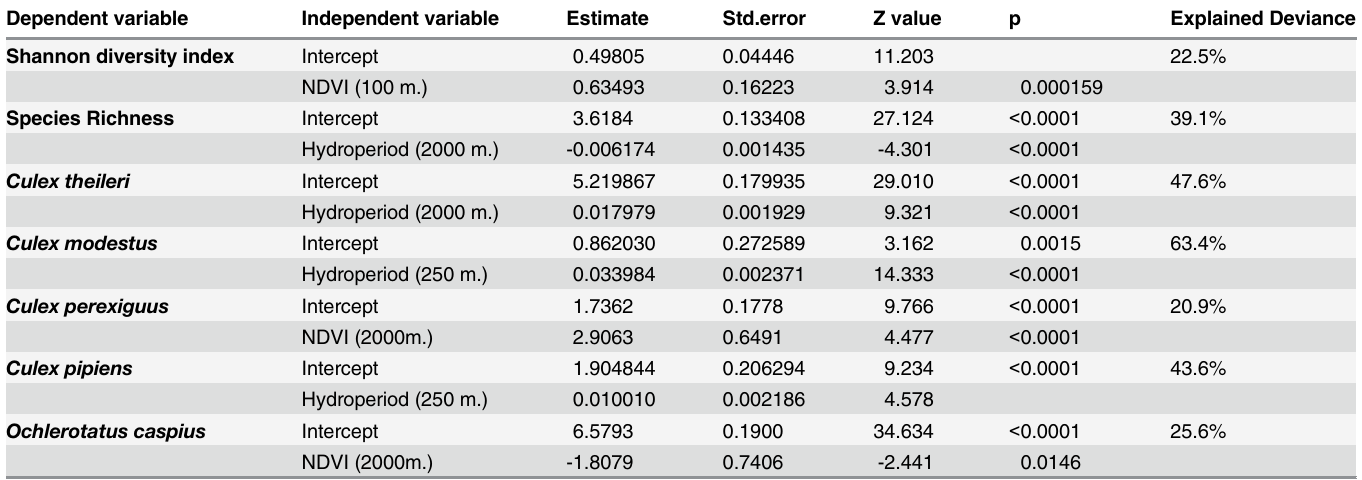
Table 3. Results of the Generalized Linear Model (normal) of diversity and mosquito species richness in relation to Hydroperiod and NDVI esti- mated at five buffers of different size; and results of the Generalized Linear Model (negative binomial) of annual female abundance for five mos- quito species in relation to Hydroperiod and